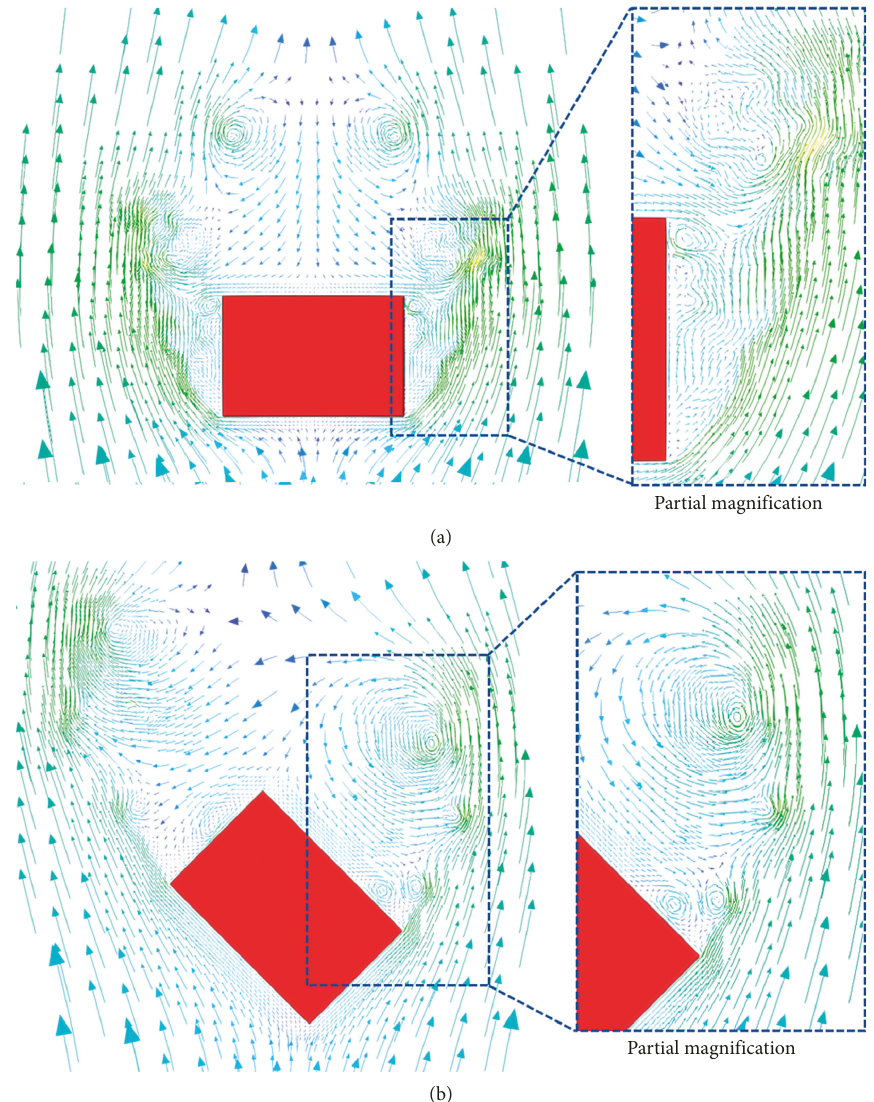
Figure 7: Velocity distribution at 2/3H height of the wale model of class D wind field. (a) 0 ° wind angle. (b) 45 ° wind